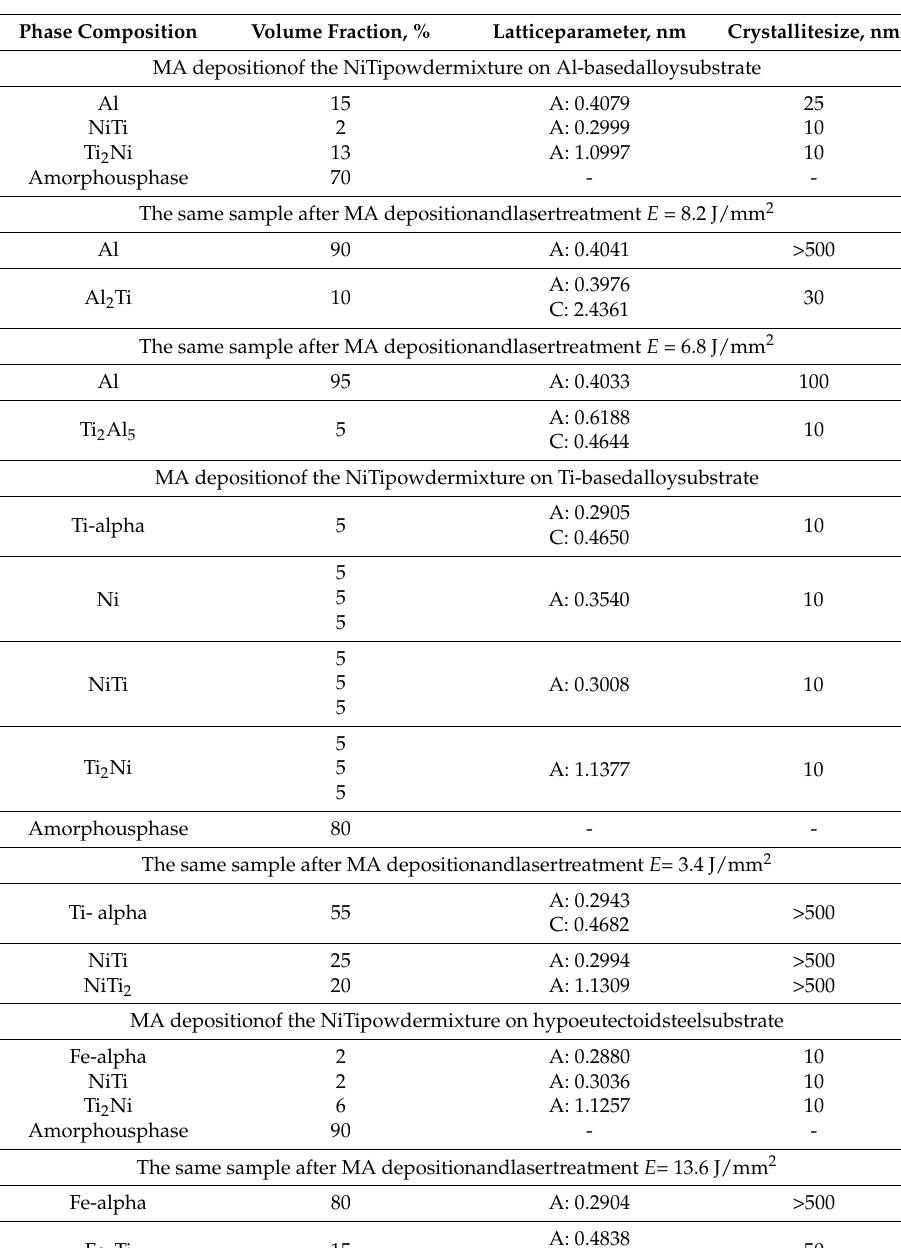
Table 1. Phase composition and structural parameters of the Ni-Ti